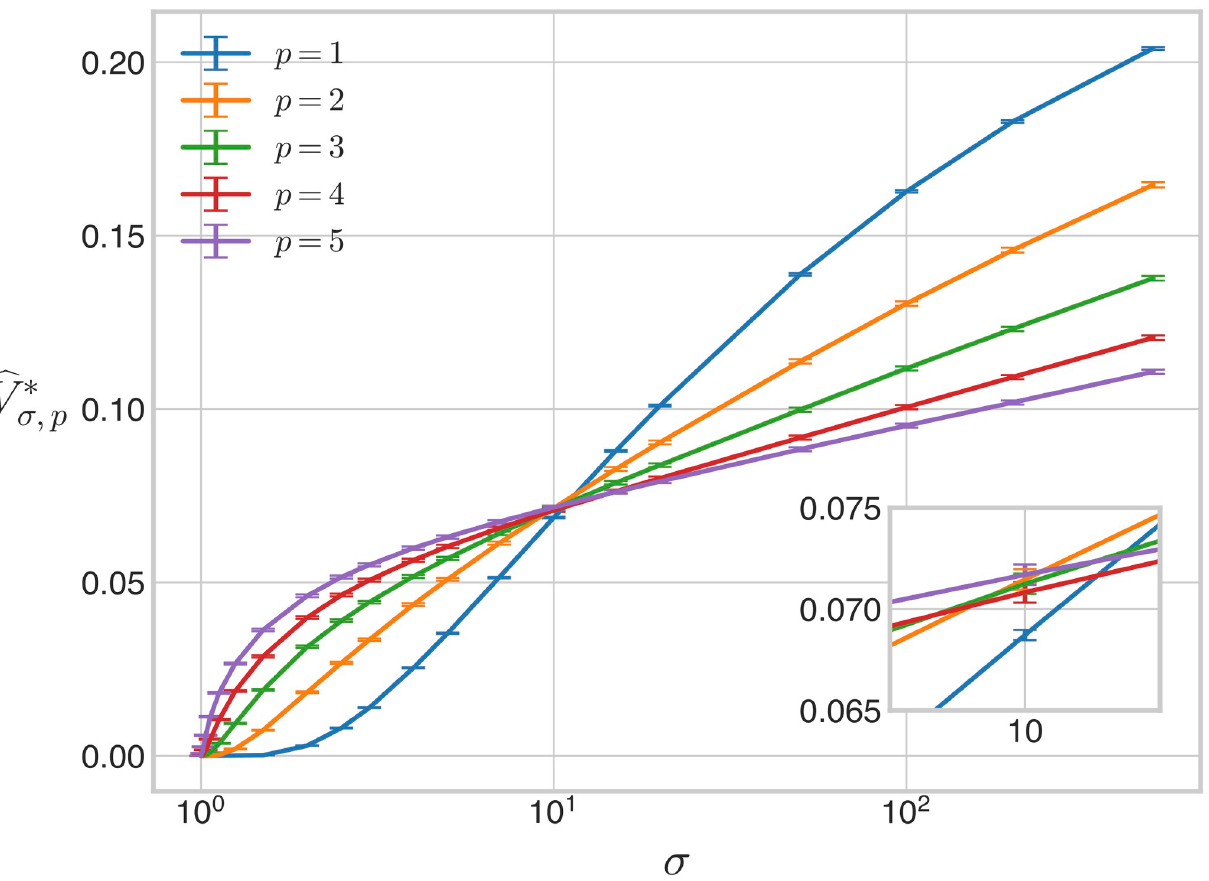
Fig 9. Volume of the bistable region outside H � under strong irreversibility. The 6-dimensional volume, b V � , of the bistable region under strong s ; p irreversibility, normalised as a proportion of the volume of the box, H � ¼ ½ 0 : 1 p ; 10 p � 6 , is plotted for the 21 values of σ in Eqs 11 and 20, for p = 2, 3, 4, 5. p The curve for p = 1 is taken from Fig 6. The error bars give 95% confidence intervals for each estimate (Materials and methods). The estimates have been joined by line segments. The inset shows the curves in the vicinity of σ = 10, at which point all five curves are close to intersecting. The 95% confidence interval for b V � does not overlap with that for b V � for p = 2, 3, 4, 5, indicating that the difference between the former and the latter is statistically 10 ; 1 10 ; p significant at the 0.05